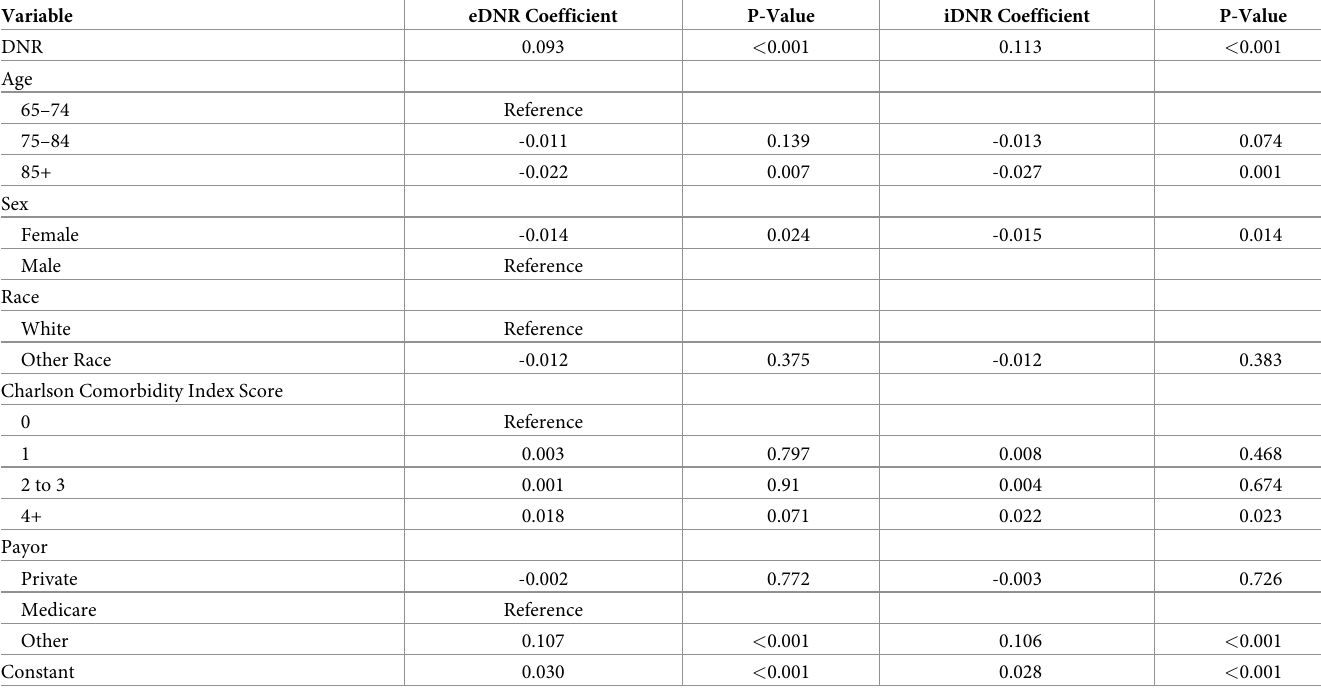
Table 4. Results of linear probability models of mortality controlling for eDNR versus iDNR as independent variables as well as other